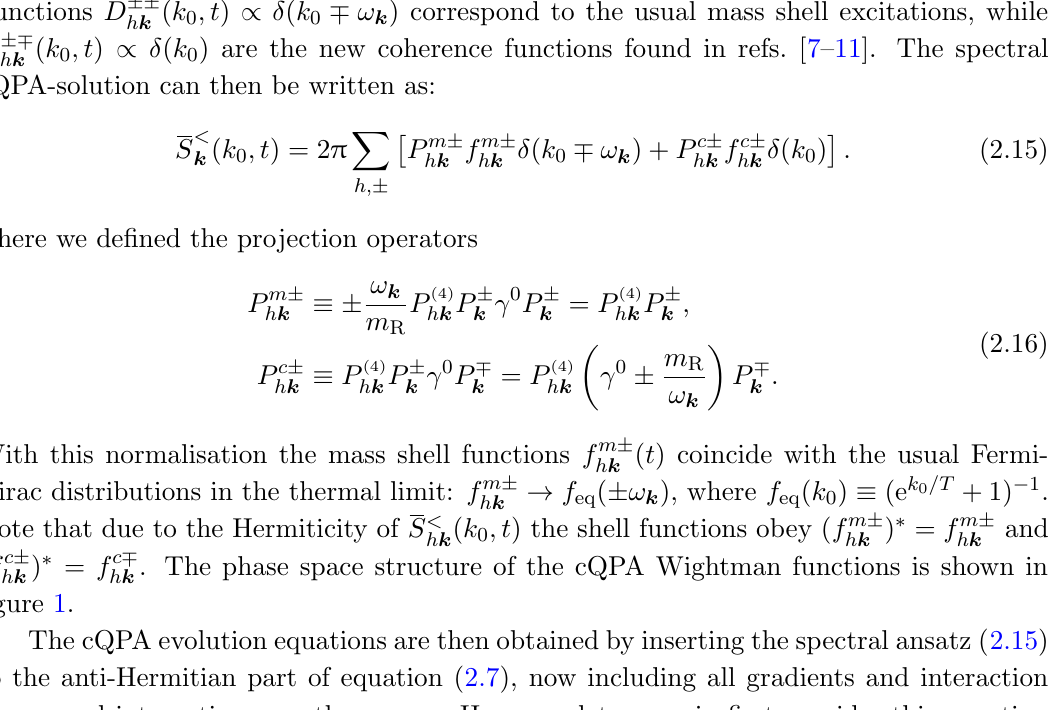
Figure 1. The shell structure of the cQPA Wightman function S < where k 0 = ! k (purple), the antiparticle shell where k 0 = (cid:0) ! k (orange) and the particle-antiparticle coherence shell where k 0 = 0